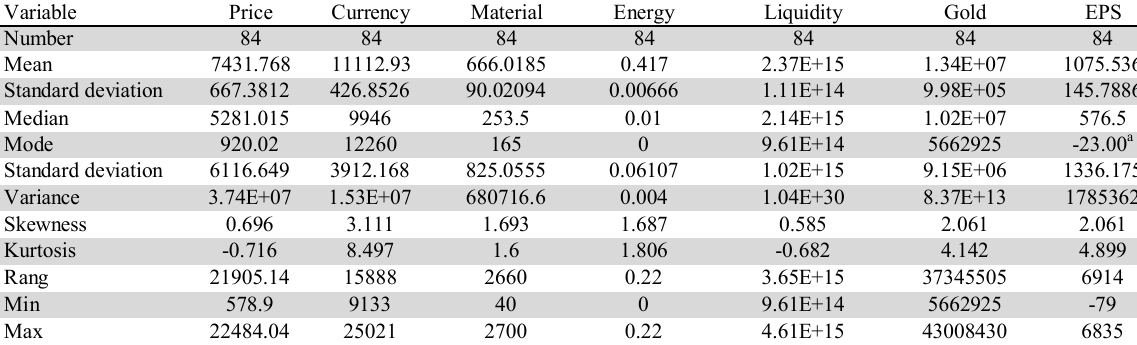
The summary of some basic